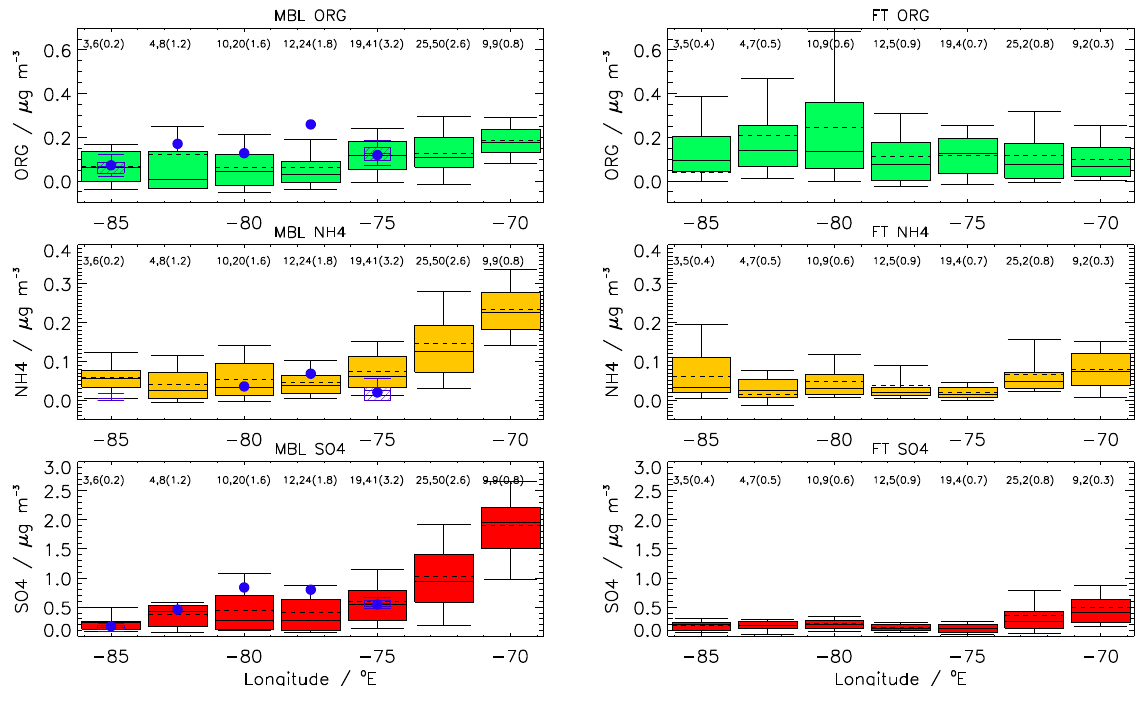
Fig. 8. Longitudinally-gridded aerosol mass concentrations for: organics (green, top panels); ammonium (yellow, middle panels); and sulphate (red, bottom panels) for the marine boundary layer between 10–1200m (left panels) and the free troposphere between 1700–3200m (right panels). For each zone, thick centre lines indicates the sample median, dashed lines indicates the mean, boxes indicate upper and lower quartiles with upper and lower decile whiskers. Median mass concentrations measured by the Ron Brown research vessel are plotted as purple circles for the marine boundary layer, with purple box and whisker plots for periods when the Ron Brown was anchored on station. Plotted above each longitude zone and for each panel, numbers before the comma indicate number of flights contributing to each statistic, followed by the number of straight and level runs, with the total sampling time in decimal hours in parentheses.